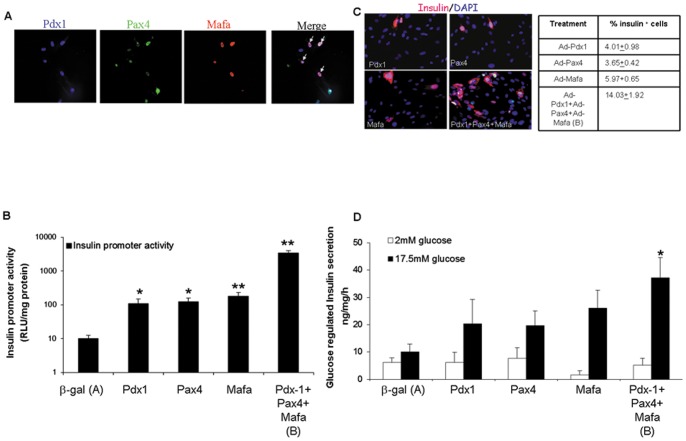
Ectopic co-expression of pTFs in the liver in vitro promotes endocrine pancreatic differentiation.Cultured adult human liver cells were infected with Ad-CMV-Pdx1 (1000 MOI), Ad-CMV-Pax4 (100 MOI) and Ad-CMV-Mafa (10 MOI) alone or in concert or with control virus (Ad-CMV-β-gal, 1000 MOI), and pancreatic differentiation markers were examined six days later. (A) Immunofluorescence staining of human liver cells ectopically treated with a combination of three pTFs; Pdx1 (blue), Pax4 (green), and Mafa (red). Arrows indicate cells positive for all three pTFs. (B) Cultures were co-infected with the combined pTFs and with Ad-RIP-LUC (200 MOI), and Luciferase activity was measured. The results are expressed as Relative Light Unit (RLU)/mg protein. Each data point represents the mean ± SE of at least 2 independent experiments preformed in cells isolated from different donors, *p<0.05, **p<0.01 in comparison to control virus treated cells (n>4). (C) Immunofluorescence staining of treated human liver cells for insulin (red). Nuclei were stained with DAPI (blue), original magnification X20. The percent of insulin-positive cells was calculated by counting at least 500 positive cells from at least 2 independent experiments preformed in cells isolated from different donors. (D) Insulin (and or pro-insulin) secretion was measured by static incubation of the cells for 15 min at 2 and 17.5 mM glucose in KRB. n>12 in 5 independent experiments preformed in cells isolated from different donors, *p<0.05 comparing between triple infection and all other treatments.